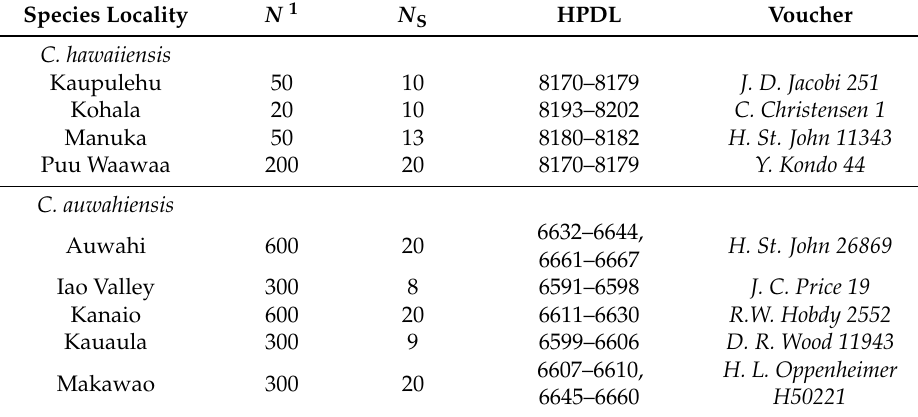
Table 5. Samples analyzed for population genetic variation of C. hawaiiensis (Hawaii Island) and C. auwahiensis (Maui Island). Species classification, locality, estimated population size ( N ), number of plant per population sampled ( N s ), DNA accession in the Hawaiian Plant DNA Library (HPDL), and representative population voucher. The topographic map of for the populations’ locations of two species are shown on Figure 1. Due to species rarity, voucher specimens were not collected with this study, but representative specimens from each locality were deposited at the B. P. Bishop Museum (BISH) are